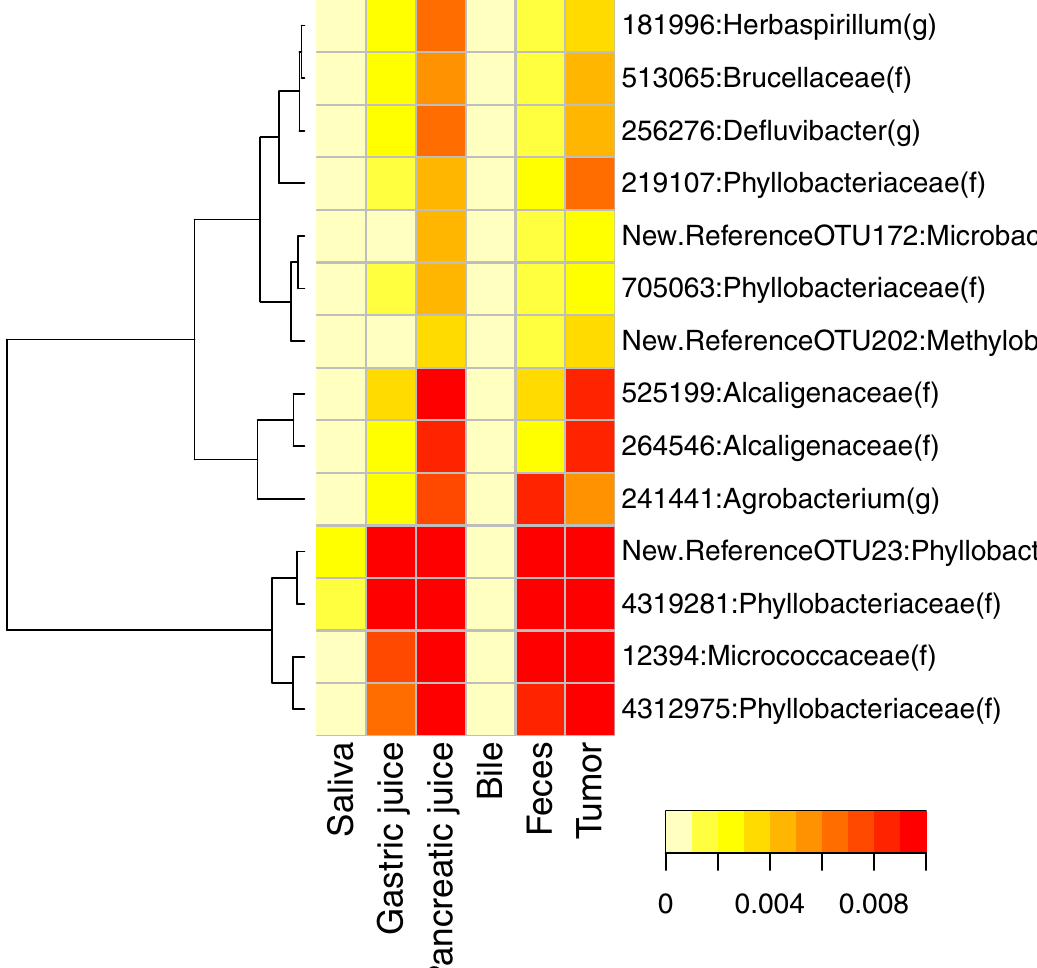
Figure 5. Bacterial origin in tumor tissue. OTUs with a relative abundance > 1% in the tumor tissue were extracted from the other body fluids and tissues. The relative abundance values of the OTUs were clustered using Euclidean distance and Ward’s